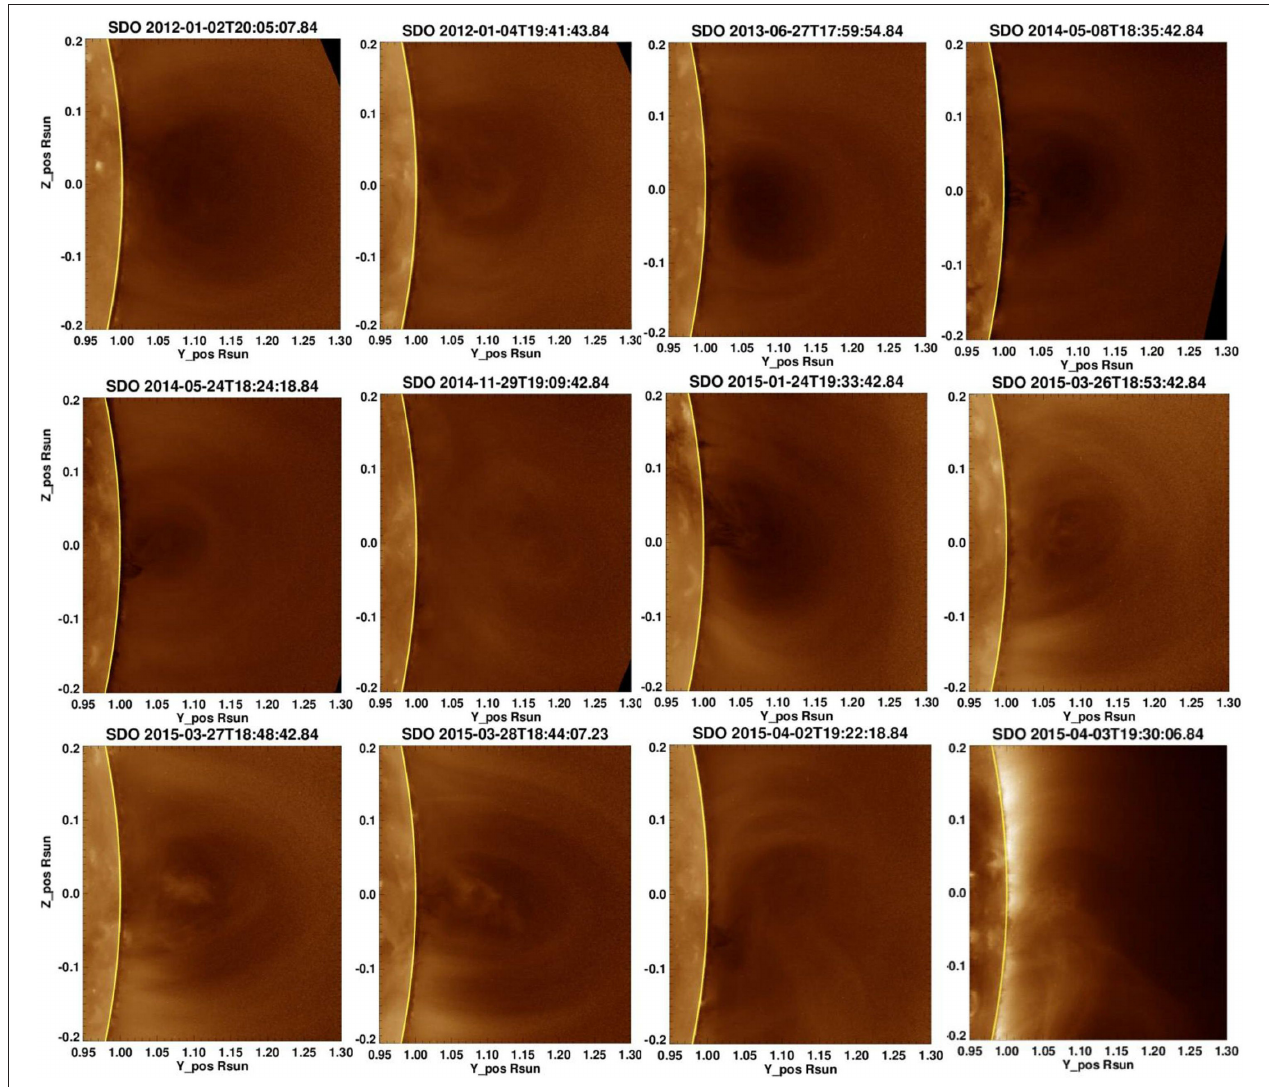
FIGURE 4 | The same cavities as in Figure 3 observed by SDO/AIA 193 Å.